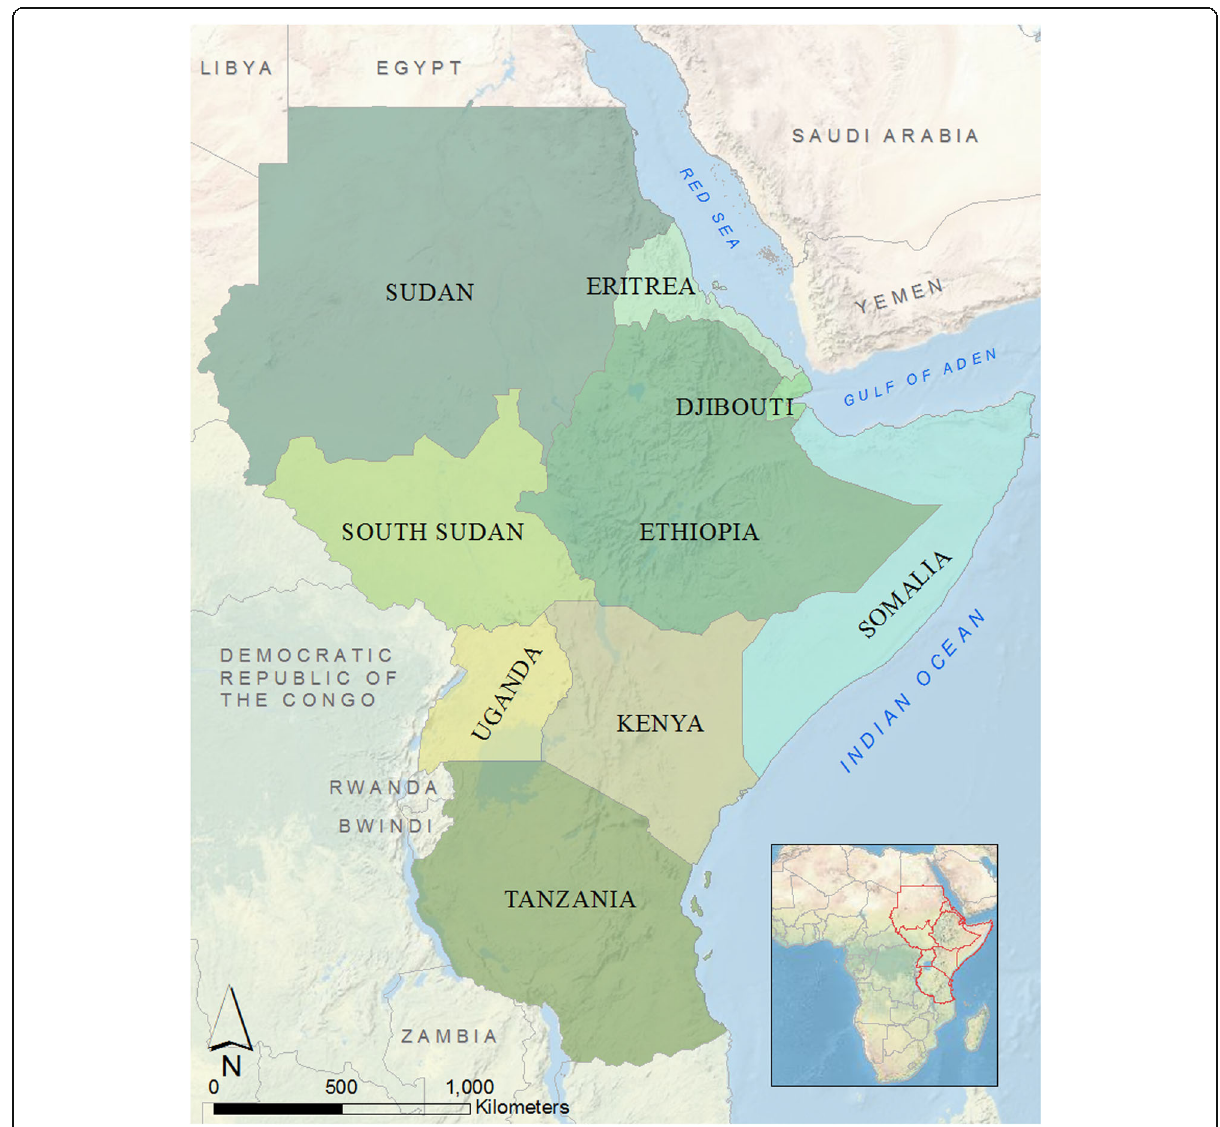
Fig. 1 The Greater Horn of Africa region. Created by EFG with ArcMap 10.6.1. Data sources: ArcGIS, US National Park